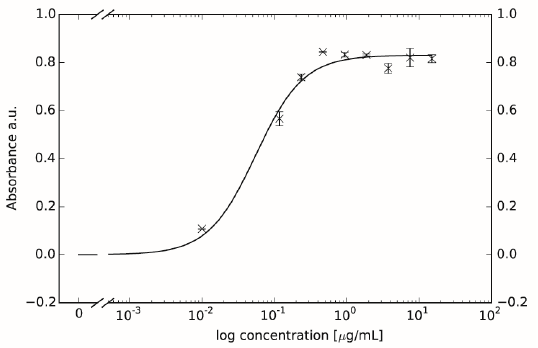
Figure A7. Dose-Response curve of EphA2 phosphorylation due to different concentration of ephrin-A1 ligand. Displayed values are averages of net absorbance (difference between absorbance at 520 nm versus 450 nm) with standard deviation presented as error bars. The calculated EC 50 value is 0.0552 ± 0.0103 µg/mL which equals 2.65 nM. PC-3 cell rounding caused by EphA2 activation from treatment with 1xSWL-DNA trimer and 2xSWL-DNA trimer.